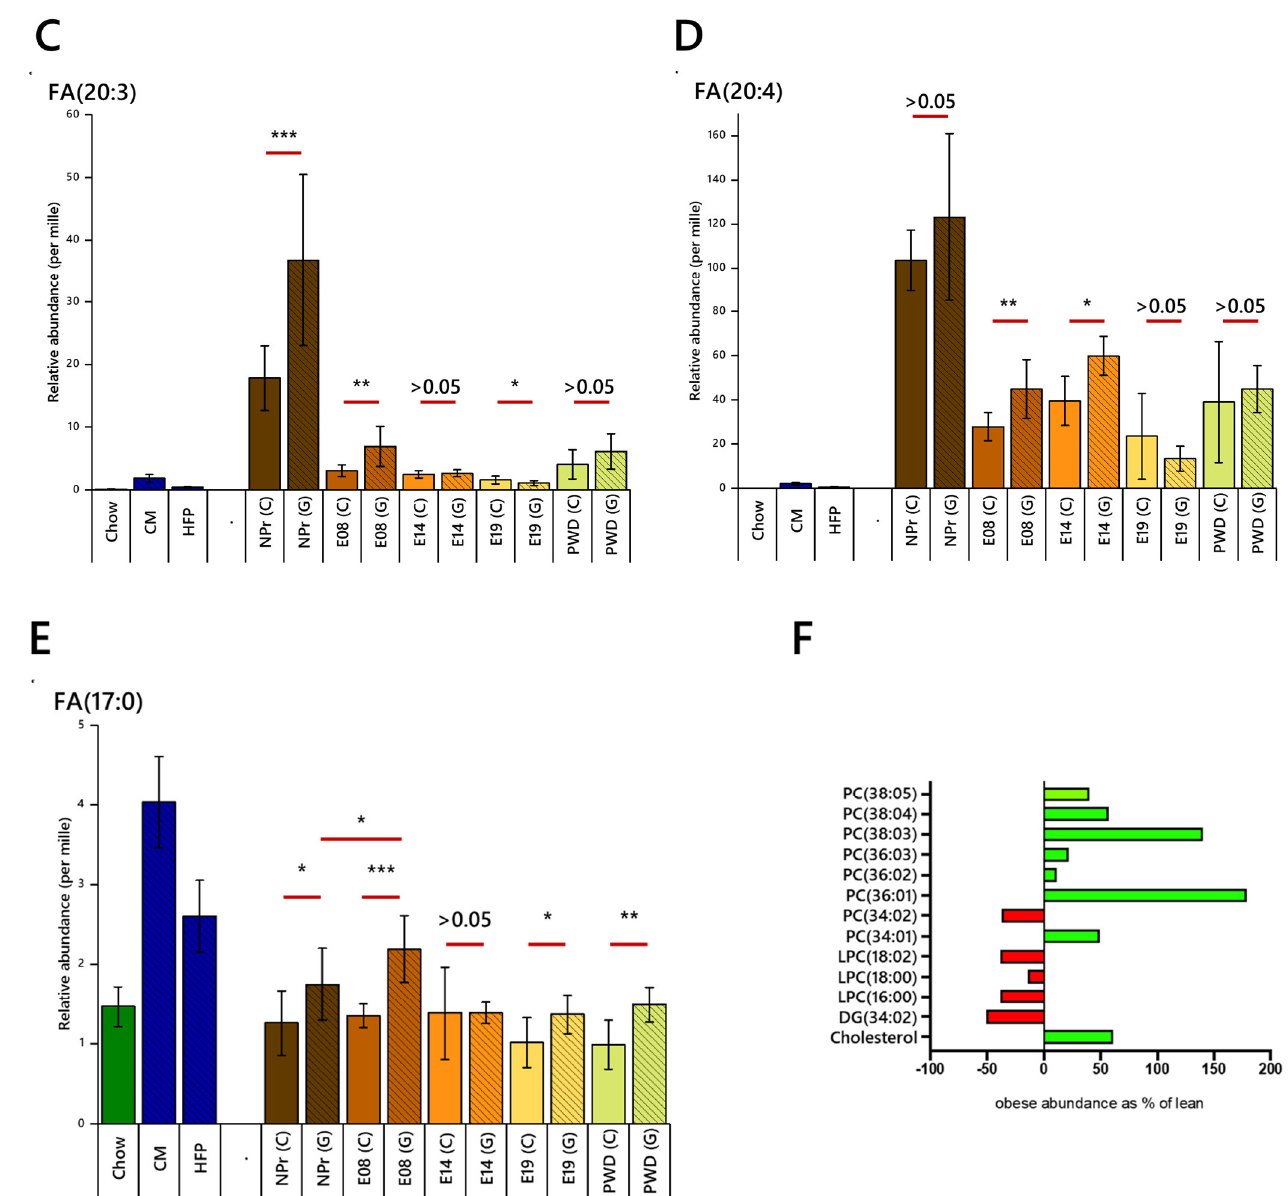
Figure 3. FA abundance (per mille) for fatty acids in the dietary intake and at non-pregnant (NPr), 8, 14 and 19 days of gestation, and post-weaning presented as means ± SD. ( Panel A ) Linoleic acid, FA(18:2); ( B ) docosahexaenoic acid (DHA), FA(22:6); ( C ) linolenic acid, FA(20:3); ( D ) arachidonic acid FA(20:4); ( E ) margaric acid, FA(17:0); ( F ) abundance of dietary-intake-associated variables between control and obese-GDM groups before pregnancy. PC, phosphatidylcholine; PE, phosphatidylethanolamine; LPC, lyso- phosphatidylcholine. *** p <0.001, ** p <0.01, * p <0.05. NPr, not pregnant; E08, 8th day of pregnancy; E14, 14th day of pregnancy; E19, 19th day of pregnancy; PWD, post-weaning dam.